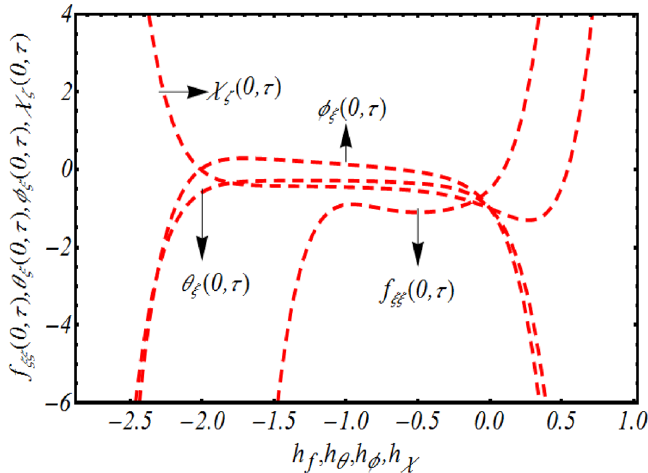
Figure 2. Representation of h -curves f ξξ ( 0, τ) , θ ξ ( 0, τ) , φ ξ ( 0, τ) and χ ξ ( 0, τ) .